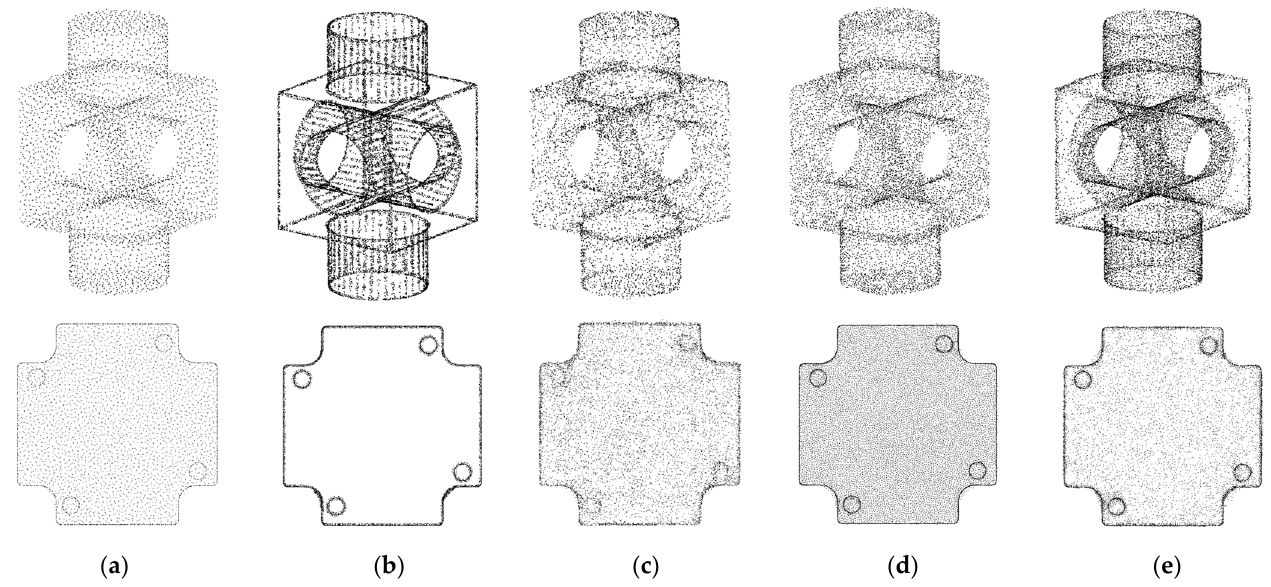
Figure 3. Qualitative verification of block (top) and cover rear (bottom). ( a ) Inputs, ( b ) ground truth, ( c ) PU-NET, ( d ) PU- GAN, ( e ) our proposed method.